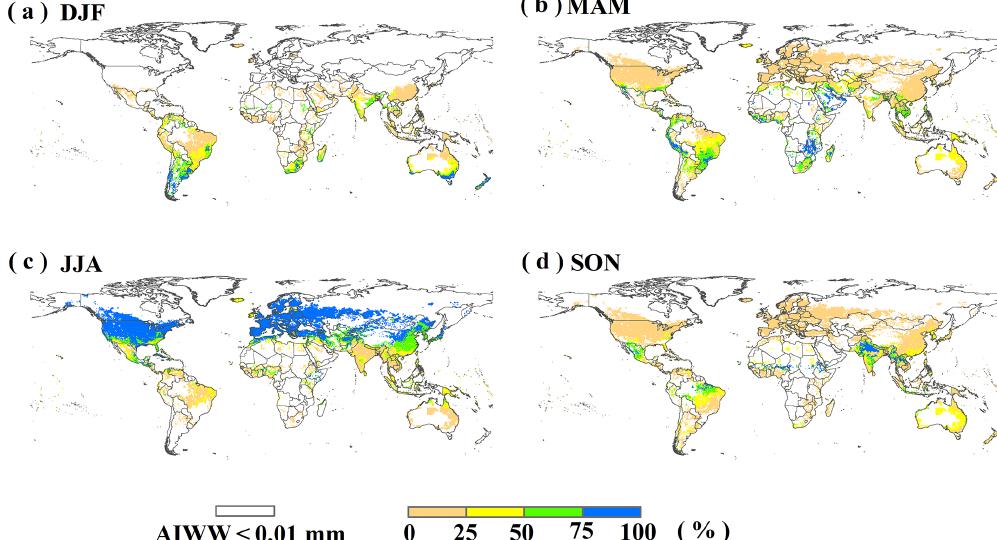
Figure 4. Relative seasonal distribution of global irrigation water withdrawal over the period 1971–2010 based on the ensemble mean of four GHMs: December to February (DJF), March to May (MAM), June to August (JJA), and September to November (SON), and grids with annual irrigation water withdrawal (AIWW) less than 0.01mm are not taken into